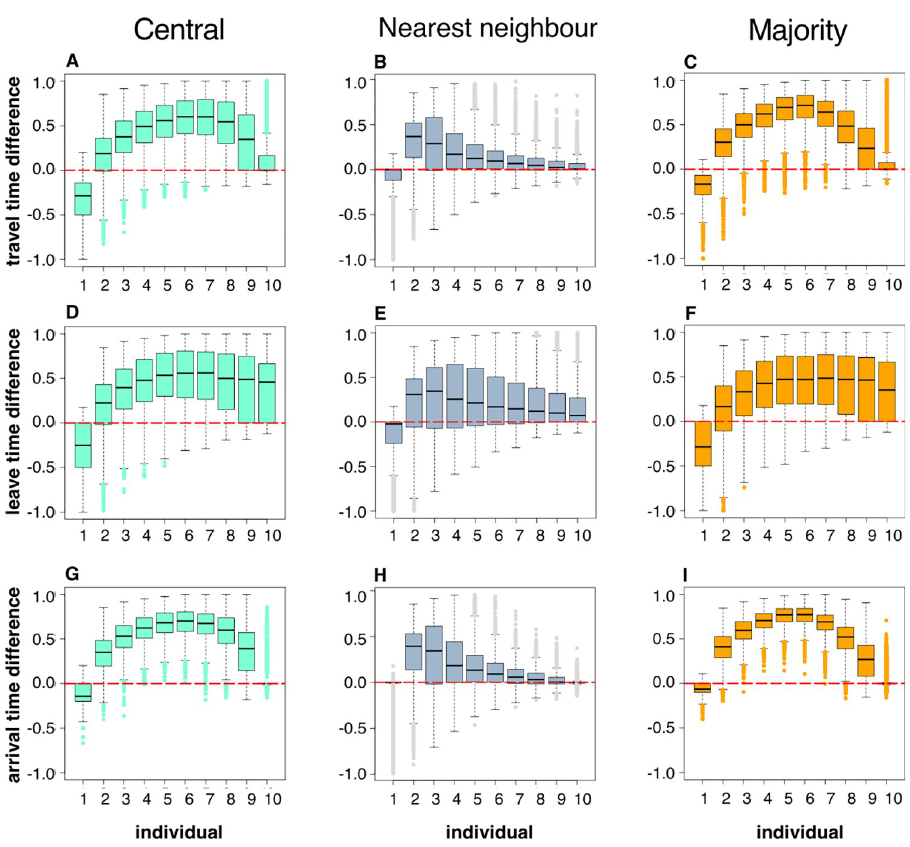
Fig 6. Mean rescaled differences in behavioural metrics between the non-social rule and each of the social interaction rules for each individual. Positive values mean that individuals switch the observed behaviour to later in the hierarchical group order when behaving socially, and negative values mean they switch to earlier in the group order when behaving socially. This means a value of 1 represents the case where the individual is always first to finish/leave/ arrive when behaving non-socially, and always the last to finish/leave arrive when behaving socially, a value of -1 represents the case where the individual is always last to finish/leave/arrive when non-social and always first to finish/ leave/arrive when social, and a value of 0 represents the case where the individual does not change the ordering of its behaviour between social and non-social behaviours ( e . g . the third individual to arrive when performing a non-social behaviour is also the third individual to arrive when performing a social behaviour). A , B and C show the difference in travel time; D , E and F show the difference in leave time; and G , H and I show the difference in arrival time. A , D and G give the values when comparing the central and non-social rules; B , E and H , the nearest neighbour and non-social rules; and C , F and I , the majority and non-social rules. See the legend of Fig 5 for a description of the boxplot ranges and the parameter set used for generating the